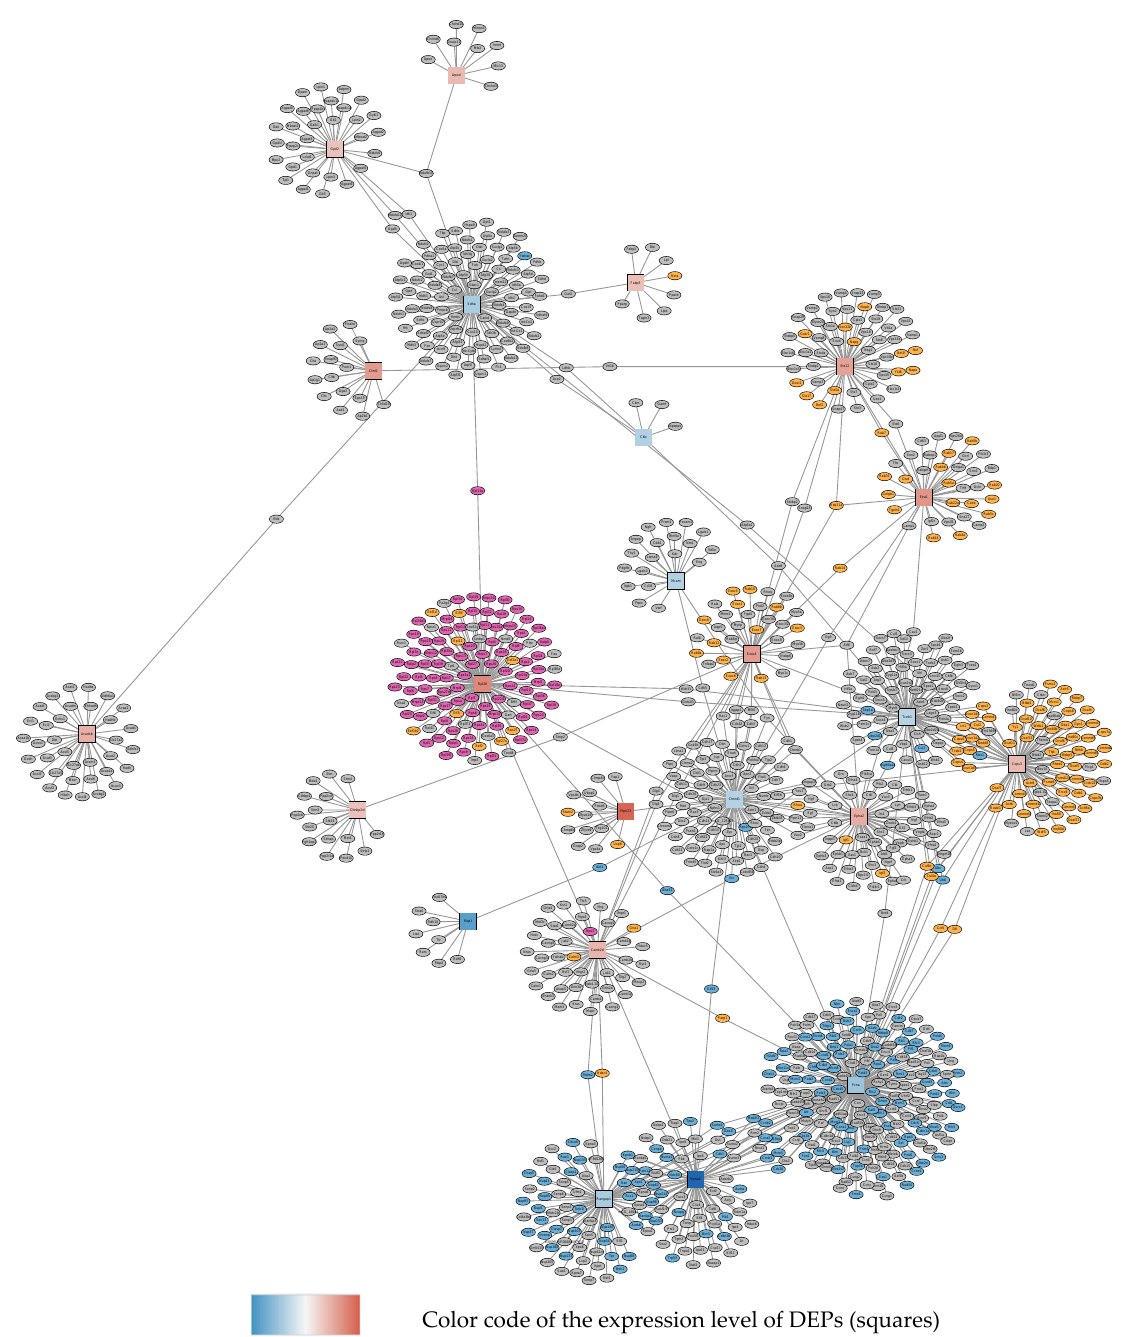
Figure 2. Subnetwork 1 of functionally associated DEPs and their interaction partners after 72 h exposure to 95% O 2 . Upregulated proteins are shown as red squares, downregulated nodes are shown as blue squares as described in Figure 1. Primary enriched pathways with FDR < 0.05 are highlighted: upregulated: metabolism of proteins (orange), ribosome (purple), downregulated: cell cycle